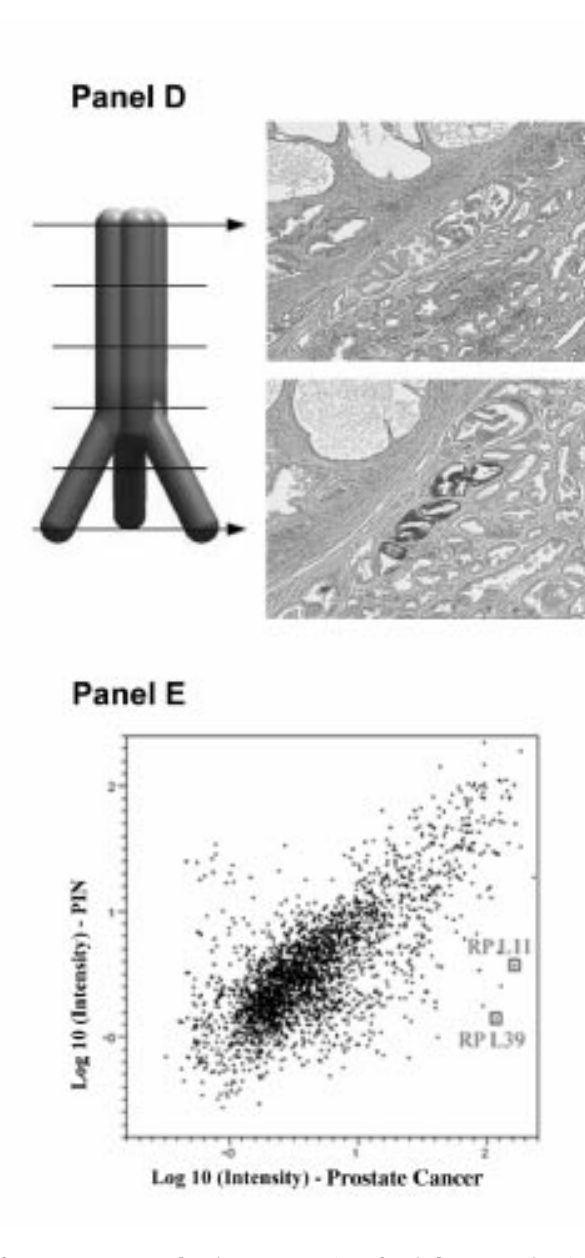
Fig. 2. Three-dimensional molecular analysis approach to the study of prostate cancer. Panel A shows an overview of a whole prostate showing the number, extent and anatomic locations of tumors at various levels of the gland. In this patient, the prostate has two tumors present, T1 and T2. The transverse view of block E (panel B) demonstrates there are two areas of high-grade cancer, T1A and T1B. In addition, there are three areas of prostatic intraepithelial neoplasia (PIN), one near the tumor (P1) and two distant (P2 and P3). There is also an area of low-grade cancer with nearby lymphocytes (L1) and abundant histologically normal epithelium (N1–4). The hyperlinked box (P2) links to a representative hematoxylin and eosin stained, high-resolution image of the region of study (panel C). The hyperlinked cube links to a serial sectioning study that has been performed on this microstructure (panel D). Panel E shows an example of a global gene expression study that compared PIN and prostate cancer using sequence analysis of cDNA libraries. Several ribosomal protein genes were expressed at significantly higher levels in cancer than PIN, including RPL11 and